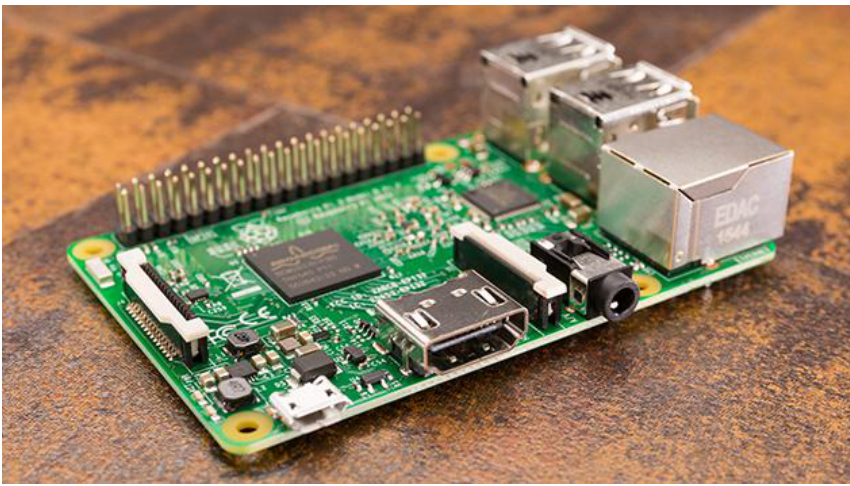
Figure 4. Raspberry Pi 3 model B was used for the